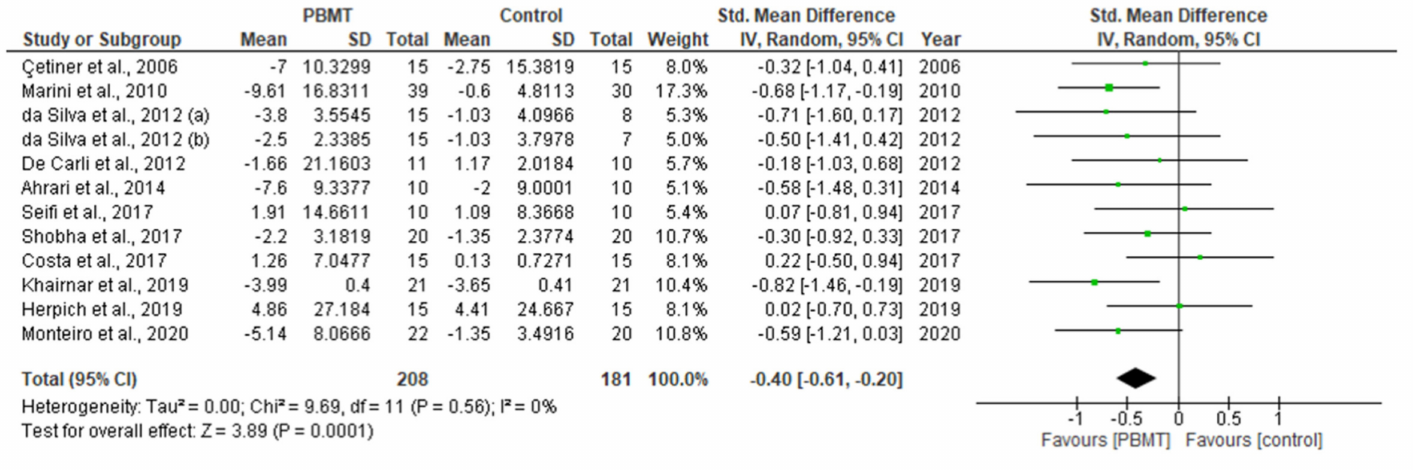
Figure 7. Forest plot for secondary outcome functionality improvement (MMO) from baseline up to the final follow-up